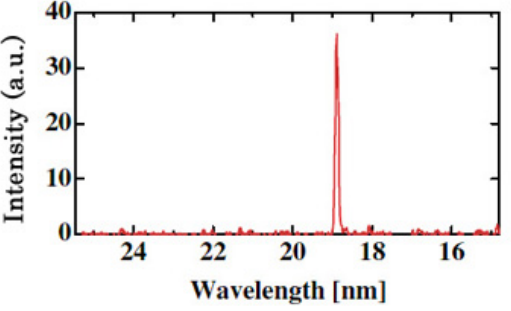
Figure 3. Intensity trace of the on-axis soft-X-ray spectrum between 15 and 25 nm is shown. The transient collisional excitation (TCE) X-ray laser has been successfully demonstrated. We observed highly directive 18.9 nm nickel-like molybdenum X-ray laser